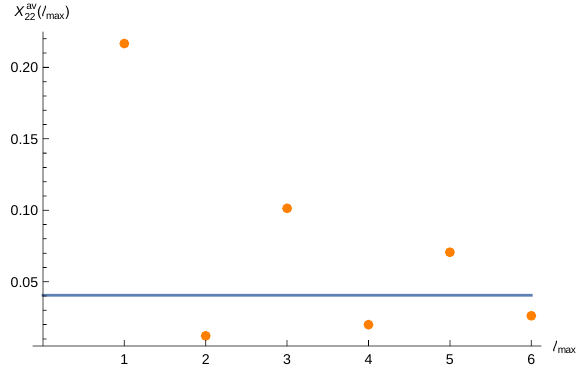
Figure 7 . Orange dots show X av horizontal line at 0 : 0405346 represents X KZ